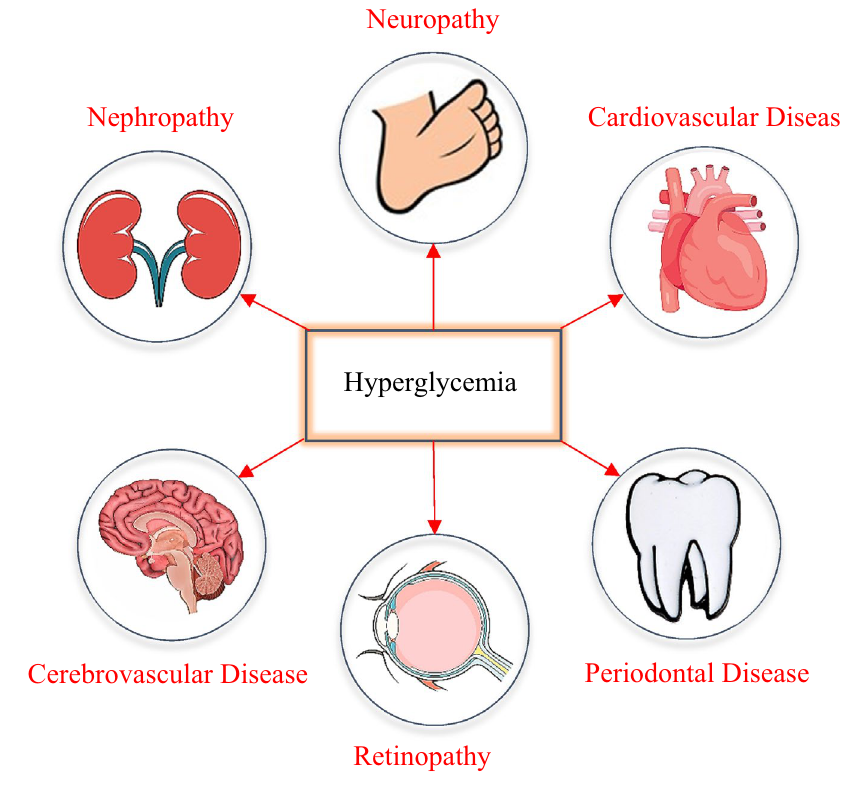
Figure 1. A schematic of the consequences of diabetes in the long